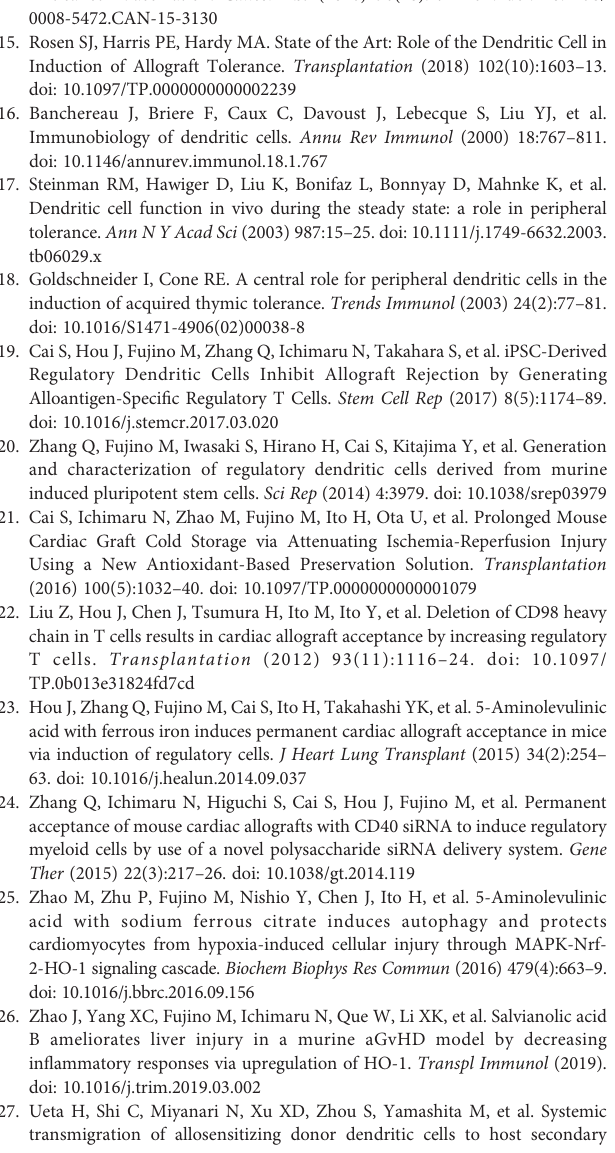
cells were gated on singlets. Next, living cells were selected, and CD3 + CD4 + lymphocytes were gated on living cells in order to determine CD25 + Foxp3 + double positive Tregs. Lower panel: Gating strategy for Treg analysis in spleen. Doublets were discriminated based on SSC-H and SSC-W, and living cells were gated on singlets. Next, living cells were gated for CD3 + lymphocytes, and then CD4 positive cells were gated on CD3 + cells. CD4 + lymphocytes were analyzed for expression of CD25 and Foxp3. Supplementary Figure 4 | The mode of action of anti-CD70 mAb in mouse cardiac allograft model. Isotype control treated C3H mice acutely rejected B6 cardiac allografts due to involvement of CD8 + CTLs, while the treatment with anti- CD70 mAb induced long-term allograft acceptance. Blocking CD70/CD27 signaling by using anti-CD70 mAb caused moderate but pleiotropic effects on different immune cell populations by decreasing CTL numbers and the induction of the tolerogenic cells populations, namely TolDCs and Tregs, which contributed to restoring the immune response to the level observed in the syngeneic mouse model and, in effect, resulted in preventing the allograft